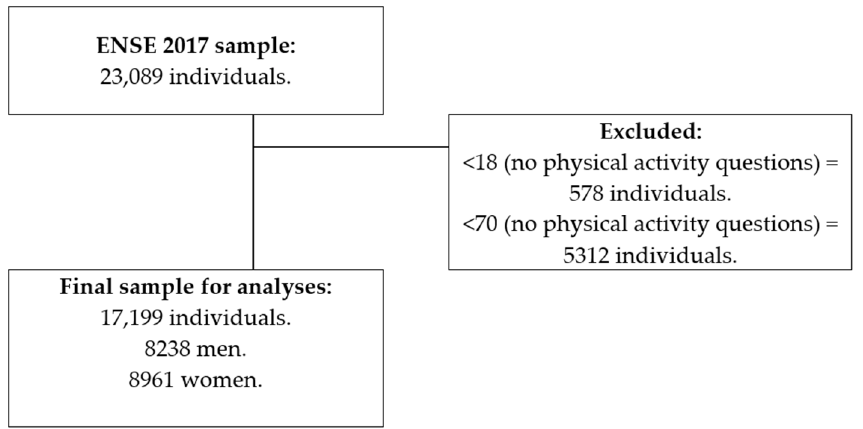
Figure 1. Chart outlining the study sample’s eligibility